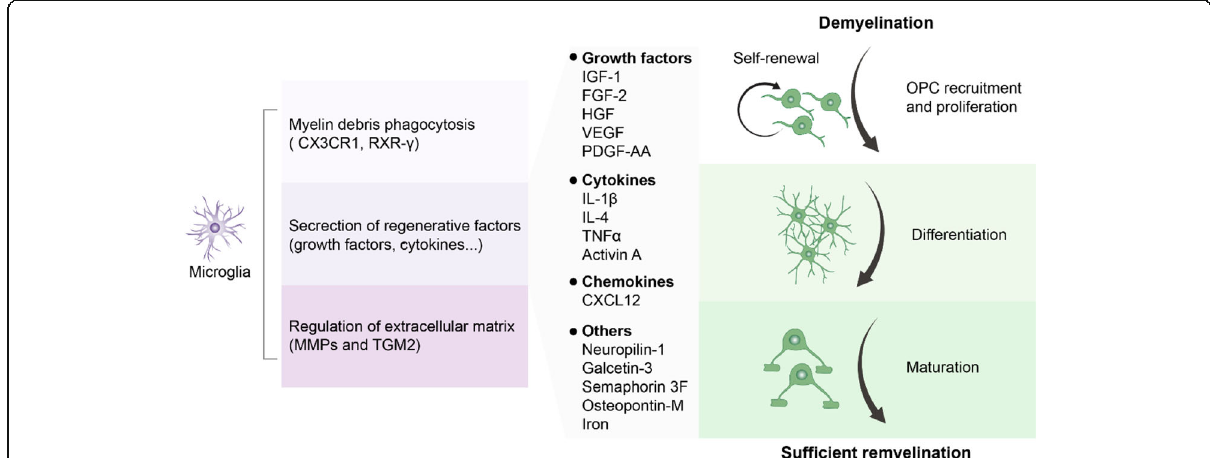
Fig. 4 Roles of microglia in remyelination. Microglia promote remyelination to facilitate OPC proliferation and differentiation for myelin formation by the following three mechanisms: (1) myelin debris phagocytosis (via CX3CR1 and RXR- γ receptors). (2) Secretion of regenerative factors such as growth factors, insulin-like growth factor 1 (IGF-1), fibroblast growth factor-2 (FGF-2), hepatocyte growth factor (HGF), vascular endothelial growth factor (VEGF), platelet-derived growth factor AA (PDGF-AA); cytokines, interleukins-1 β and 4 (IL-1 β , IL-4), tumor necrosis factor α (TNF α ), activin A; chemokine, C-X-C motif chemokine ligand 12 (CXCL12); and others, including neuropilin-1, galectin-3, semaphorin 3F, osteopontin-M, and iron. (3) Modulation of the extracellular matrix by secretion of matrix metalloproteinases (MMPs) and